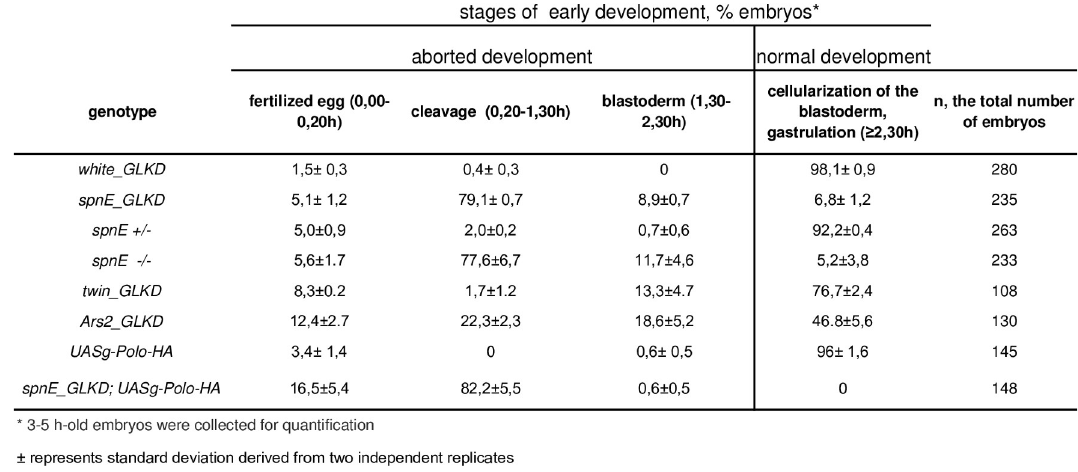
Fig 5. Maternal-effect embryonic lethality accompanying HeT-A